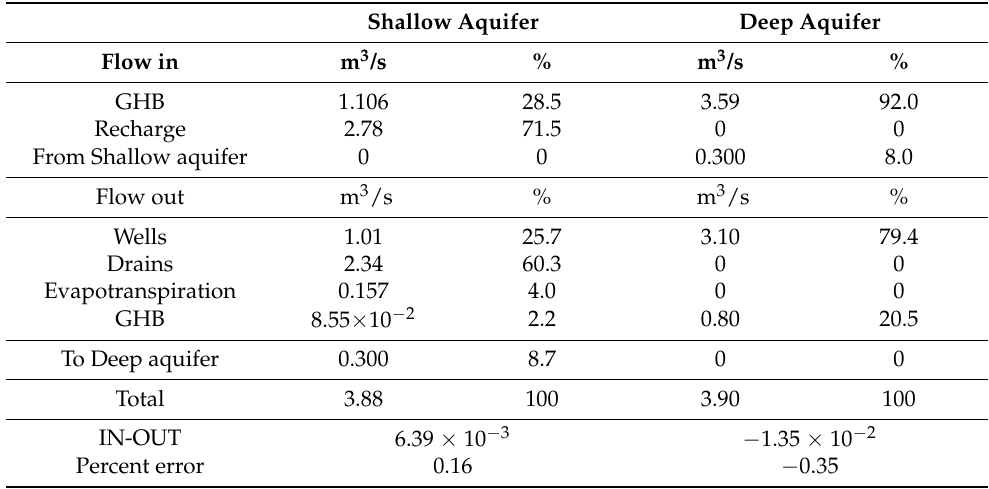
Table 3. Groundwater balance of the shallow and deep aquifers: GHB (Head Dependent flux